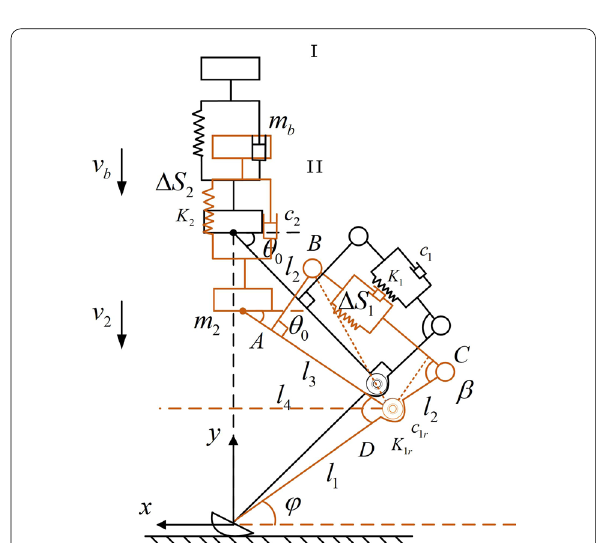
Figure 19 Working process of the multistage buffer